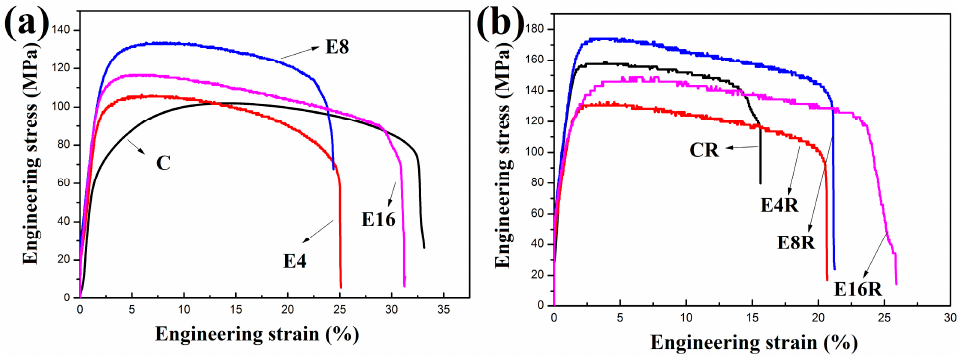
Figure 5. Tensile strain-stress curves of Mg-9Li alloys: ( a ) Cast and ECAPed alloys; ( b ) cast rolled and ECAP-rolled alloys.